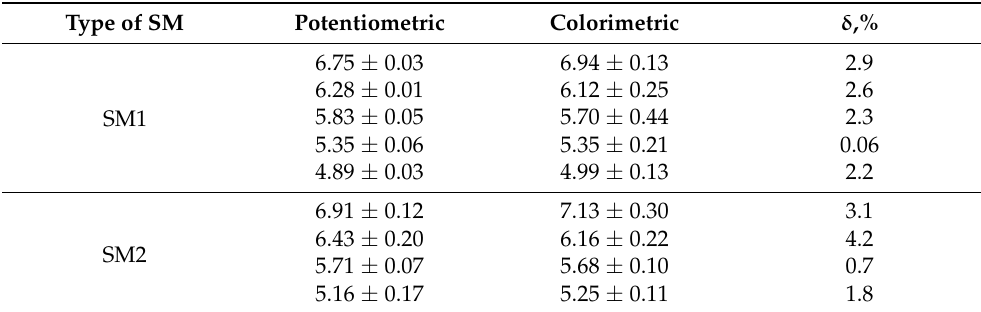
Table 5. Validation of the pH obtained in milk by colorimetry with the pH from potentiometry ( n =